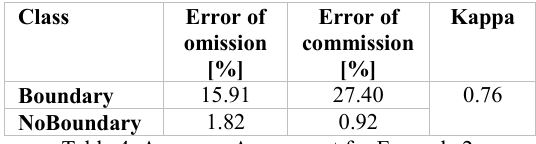
Table 4. Accuracy Assessment for Example 2.